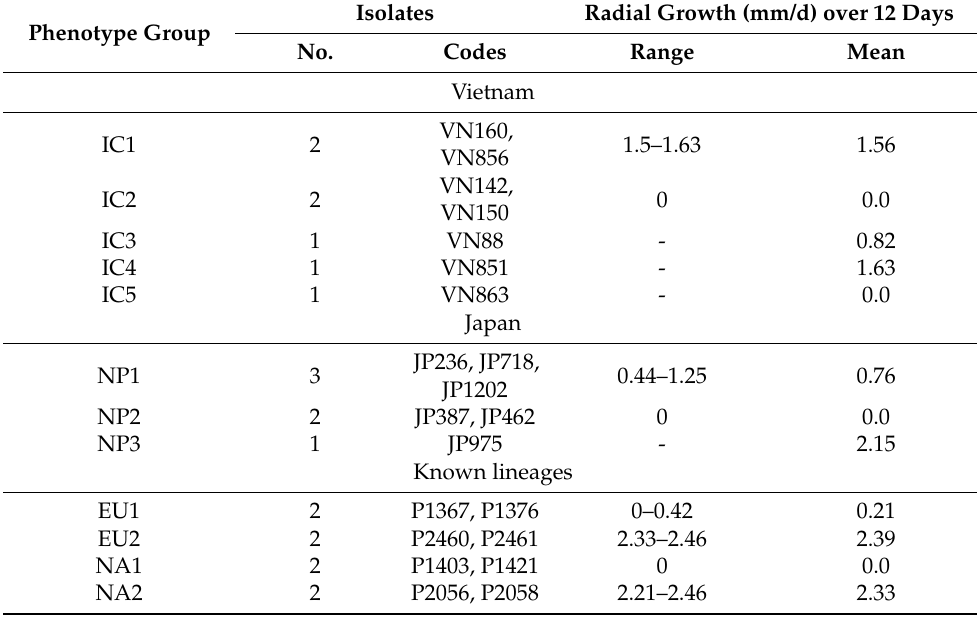
Table 1. Growth x environment stress responses of the Indochinese (IC) and Japanese (NP) phenotype groups and the known lineages of Phytophthora ramorum on 2% V8-juice agar at 28.5 ◦